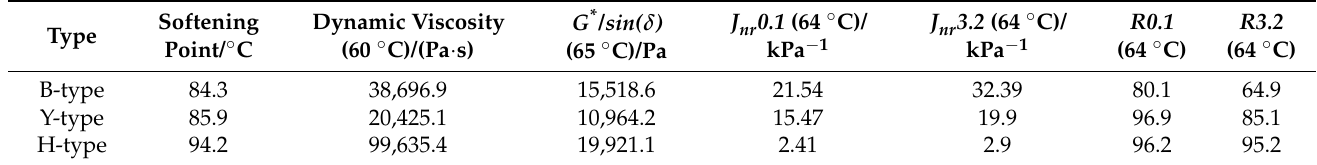
Table 3. Different evaluation indexes of high-temperature property. Table 3. Di ff erent evaluation indexes of high-temperature property.